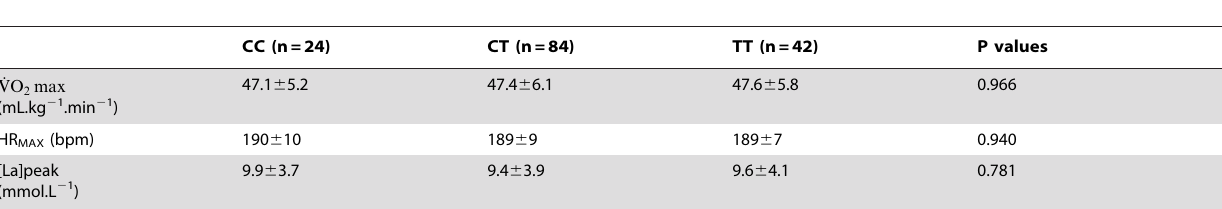
Table 2. Physiological variables measured during the maximal incremental test in the three genotype